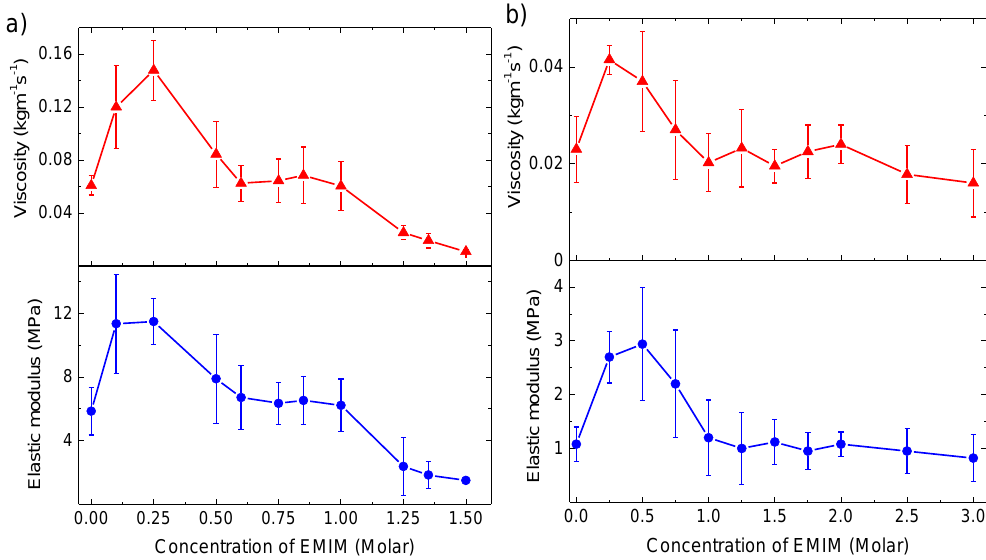
Figure 4. Modeled viscosity and elastic modulus of the ( a ) PEI(PSS/PDADMAC) 4 PSS and ( b ) PEI(PSS/PAH) 4 PSS multilayers vs. the concentration of EMIM solution used for the multilayer swelling in reversible cycles. The error bar is the standard error and calculated over 3 modeling data at the respective EMIM concentration.